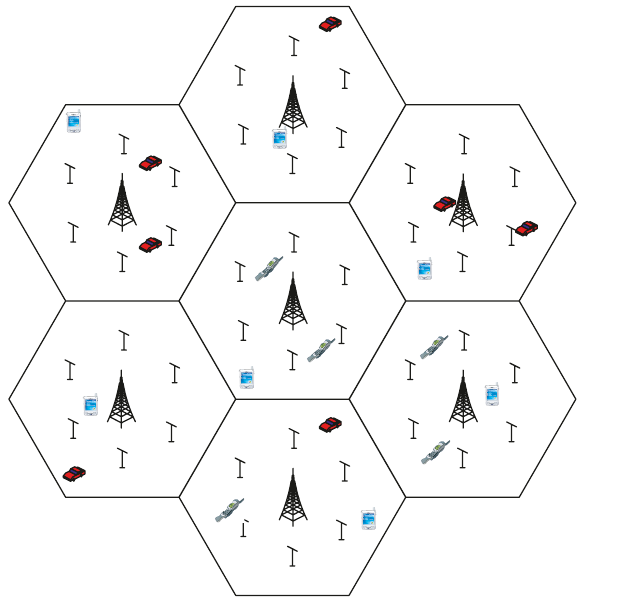
Figure 1: System layout of cooperative relaying communication.